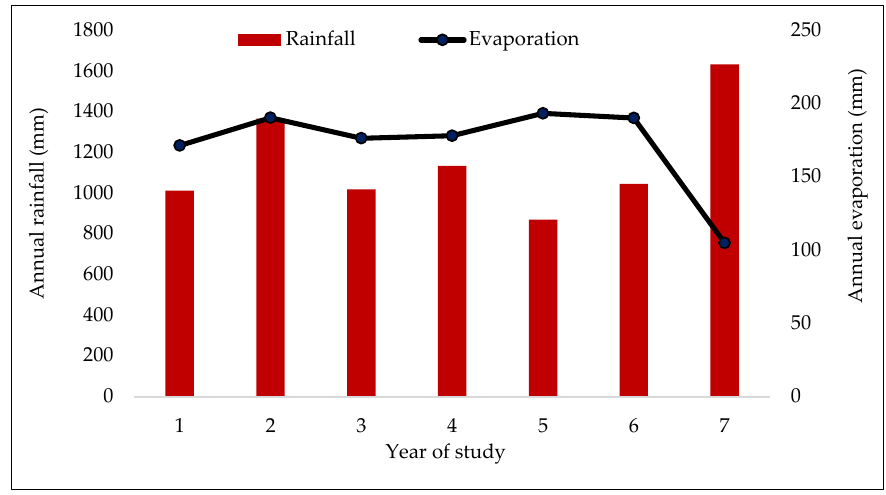
Figure 1. Annual rainfall and evaporation during experimental years.